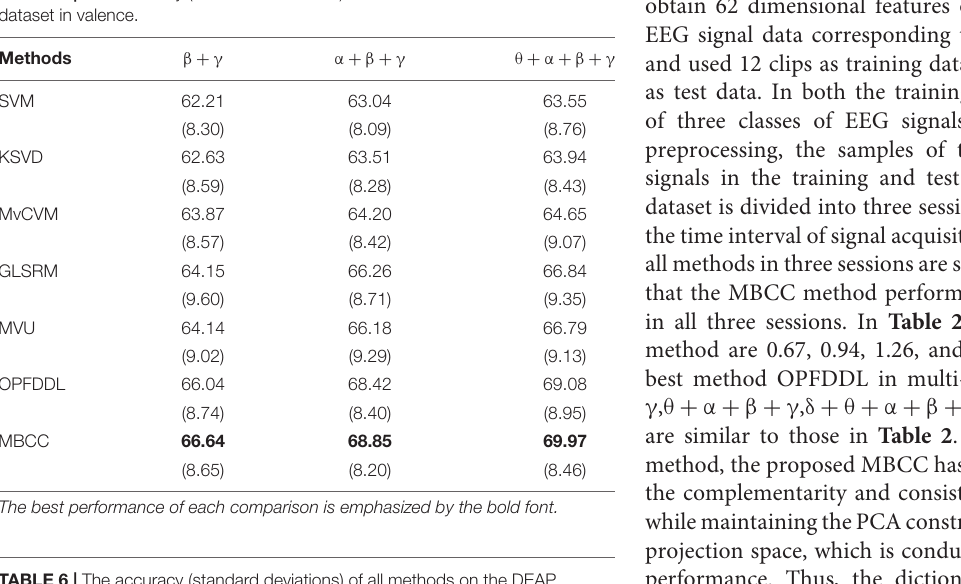
TABLE 6 | The accuracy (standard deviations) of all methods on the DEAP dataset in arousal.